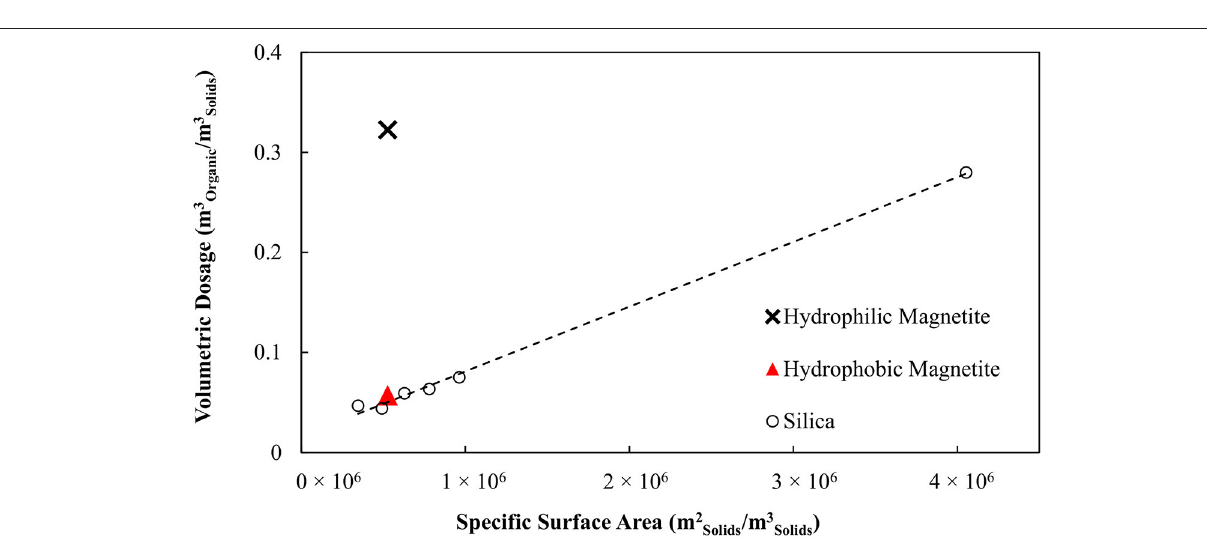
Frontiers in Chemistry |